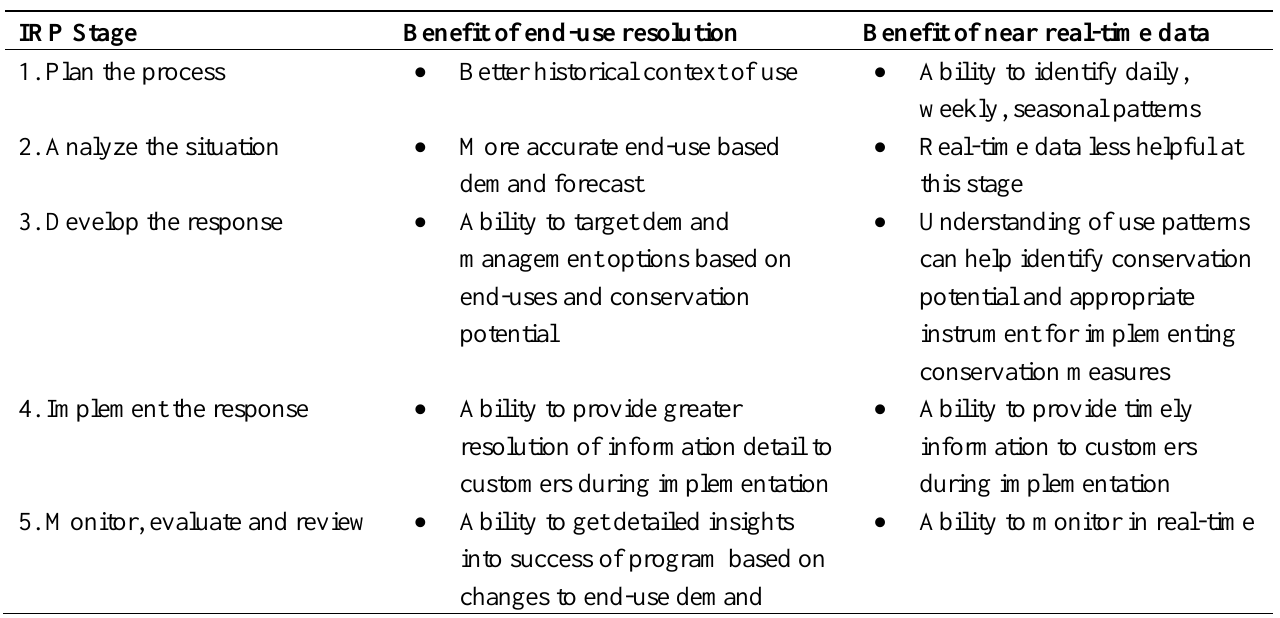
Table 1. Benefits of end-use data supplied by smart metering at each stage of Integrated Resources Planning